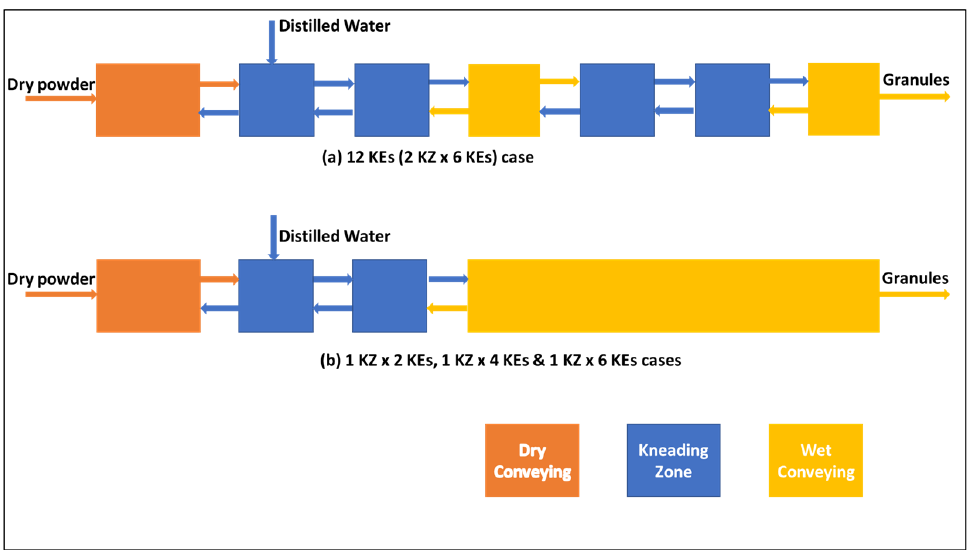
Figure 1. Schematic showing ( a ) 7 compartment modeling of equipment for 12 KE configurations; and ( b ) 4 compartment modeling of equipment for 2, 4, and 6 KE